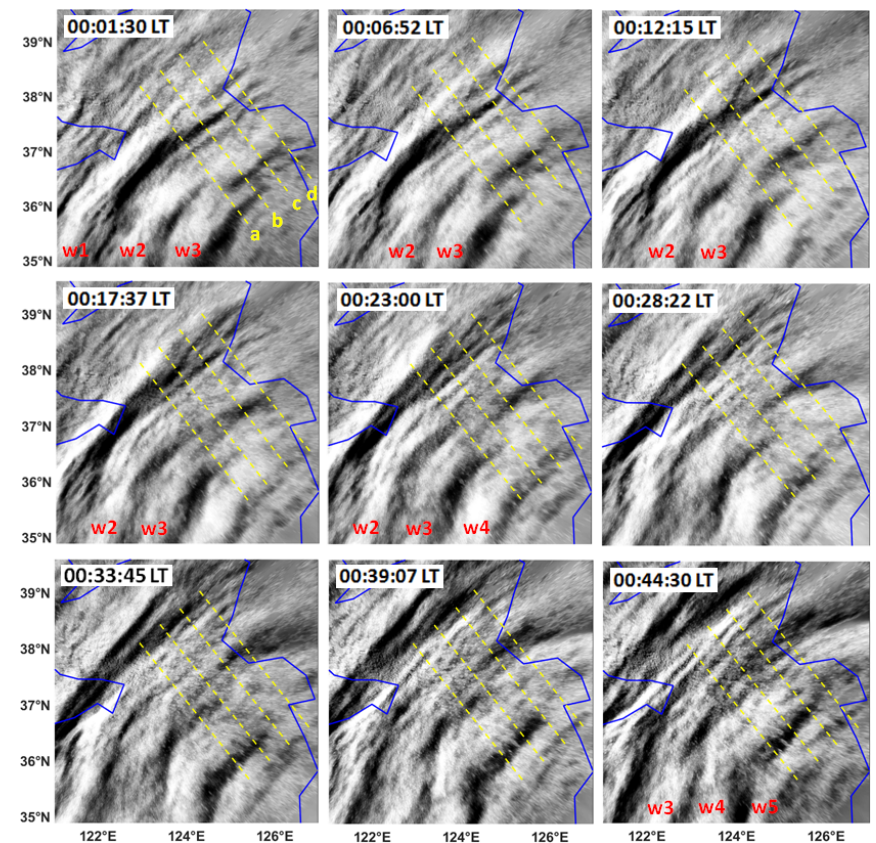
Figure 10. Time sequence of OH airglow emission perturbation images observed by the Rongcheng station from 01:01:30–00:44:30LT on the night of 4 October 2016. w1–w5 denote the wavefronts of the CGW. The blue line in each panel represents the